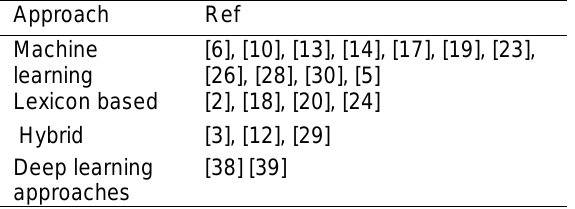
Table 1. Comparative study by